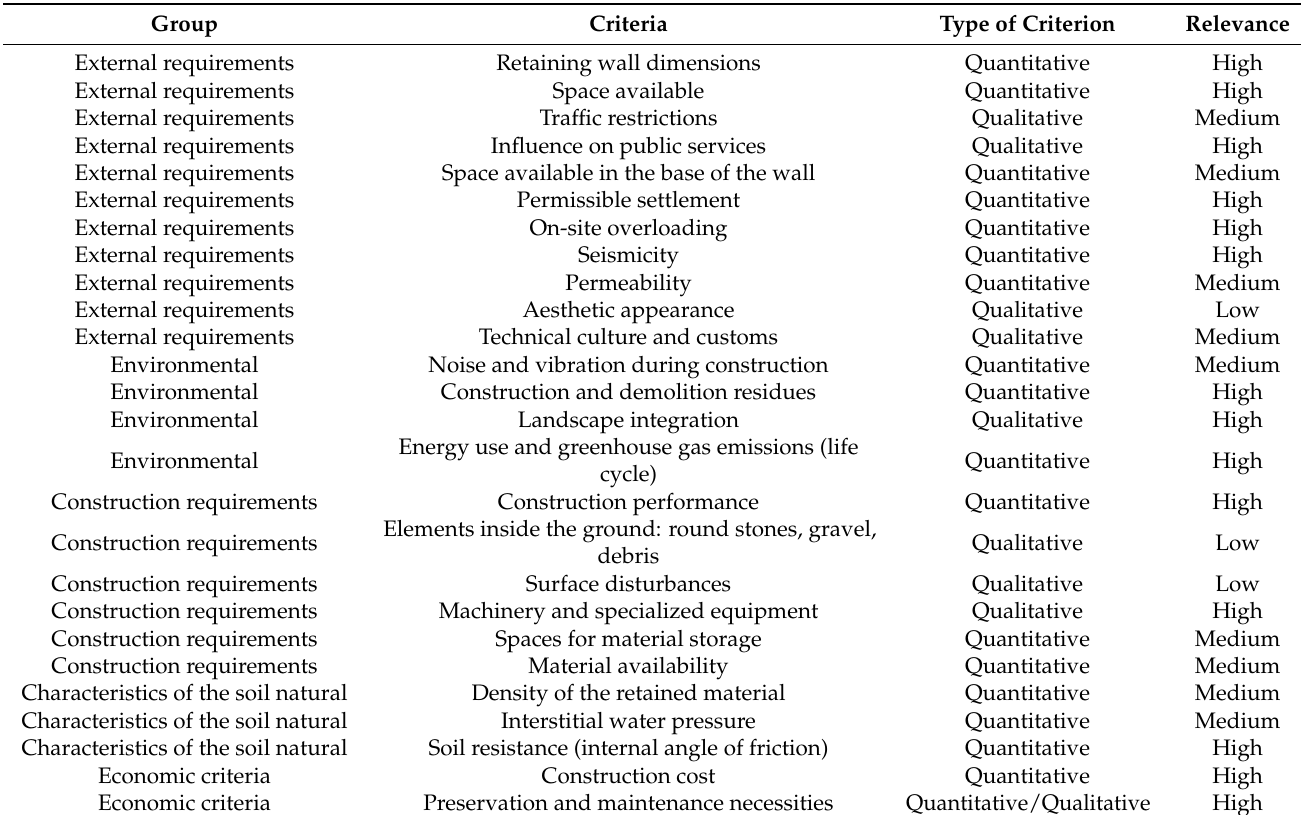
Table 2. Selection criteria. Source: the authors’ own research.